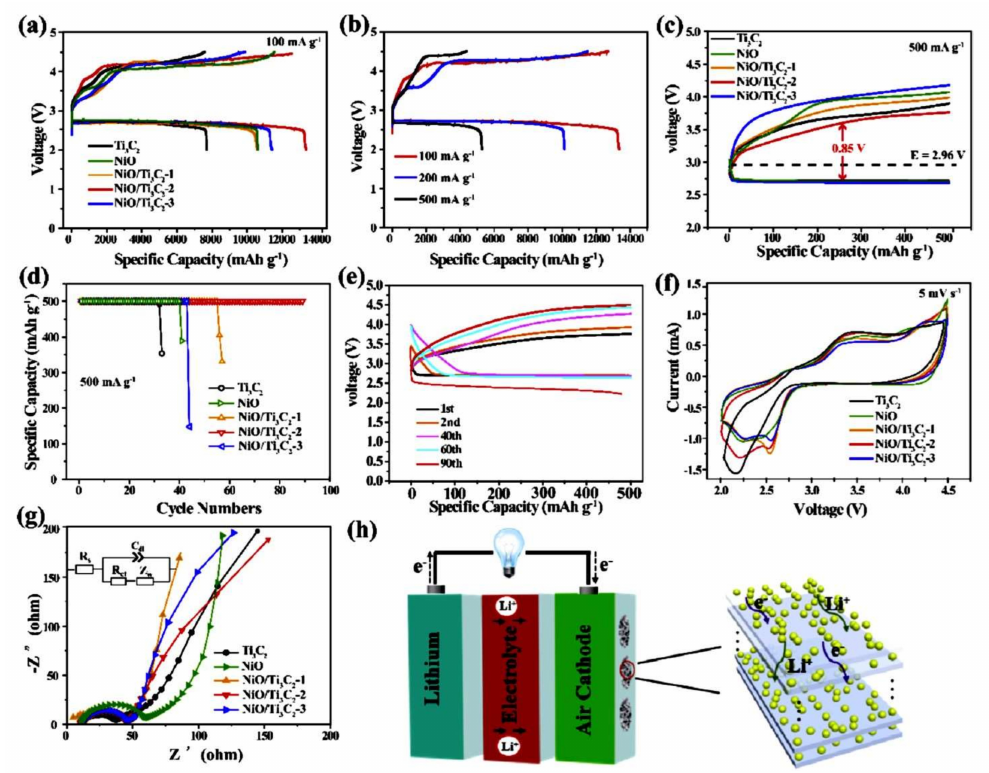
Figure 9. ( a ) GCD profile of an LOB using NiO-based Ti 3 C 2 catalysts @ 100 mA g − 1 . ( b ) GCD